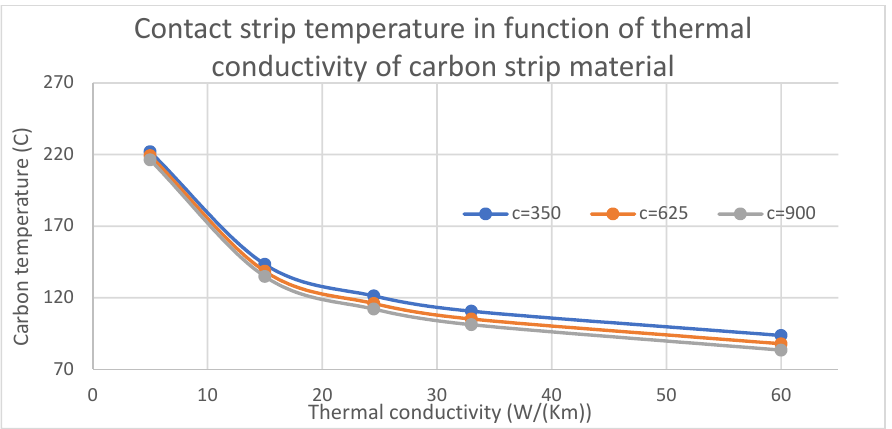
Figure 16. Contact wire temperature as a function of thermal conductivity of carbon strip material. Table 6. Summary of the influence of the thermal conductivity and specific heat factor on the max- imum temperature of the aluminum profile. Of interest is the dependence of the effect of thermal conductivity on the aluminum profile temperature. The highest temperatures of aluminum profiles were obtained for values in the range of k (15;25) W/(m × K), whereas the higher the value of c (specific heat coefficient), the higher the temperature of the aluminum profile–Figure 17.